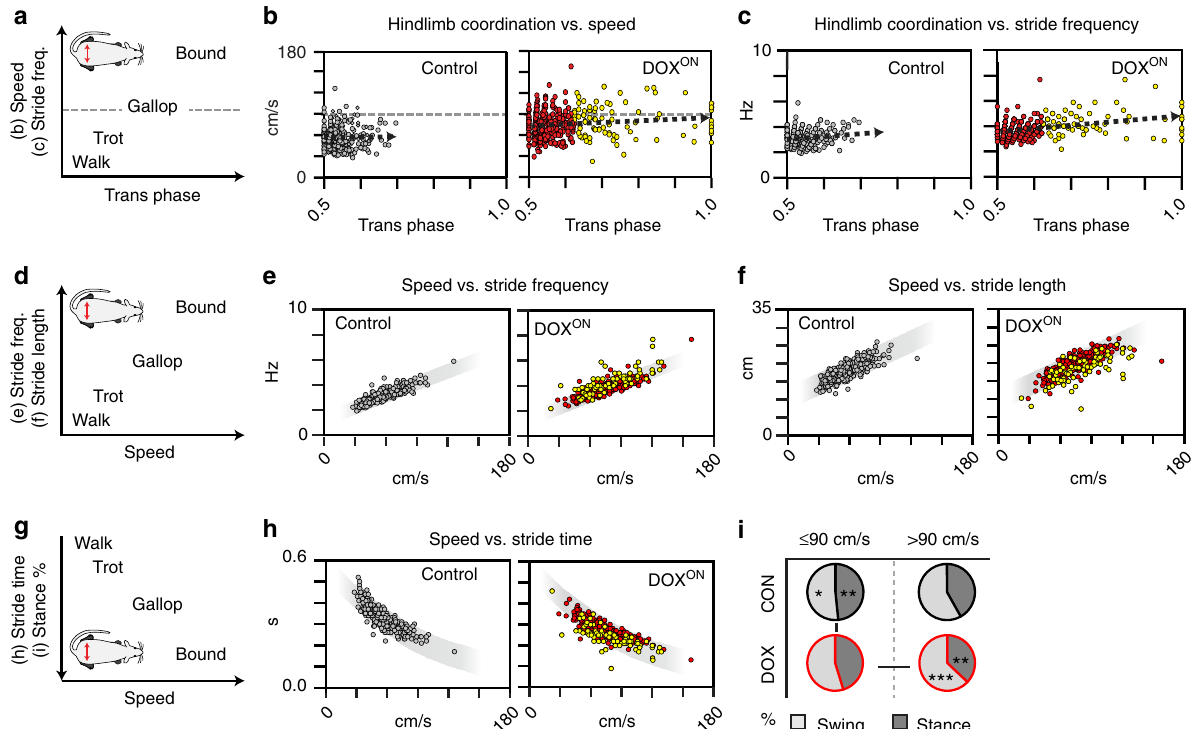
Fig. 6 Silencing L2 – L5 interneurons disrupts hindlimb alternation independent of speed and step frequency while preserving salient features that govern locomotion. a Schematic illustrating the general relationship between speed/step frequency and locomotor gaits. Dashed gray line indicates reported transition between the alternating trot and asynchronous gallop in the adult rat. b Silencing-induced changes in hindlimb coordination did not correlate with increased speed (Control, r S = − 0.01, R 2 = 0.01%; DOX ON , r S = 0.13, R 2 = 1.69%; Spearman's rank; see Supplementary Figure 3) nor increased c step frequency (Control: r S = 0.04, R 2 = 0.16%; DOX ON : r S = 0.33, R 2 = 10.89%). d , g Schematics indicating the general relationship between speed and various spatiotemporal gait indices. Silencing L2 – L5 interneurons does not affect these stereotypic associations, including e speed vs. step frequency (CON r = 0.87, R 2 = 75.69%; DOX r = 0.83, R 2 = 68.89%), f stride length (CON r = 0.81, R 2 = 65.61%; DOX r = 0.78, R 2 = 60.84%), h stride time (CON S S S S